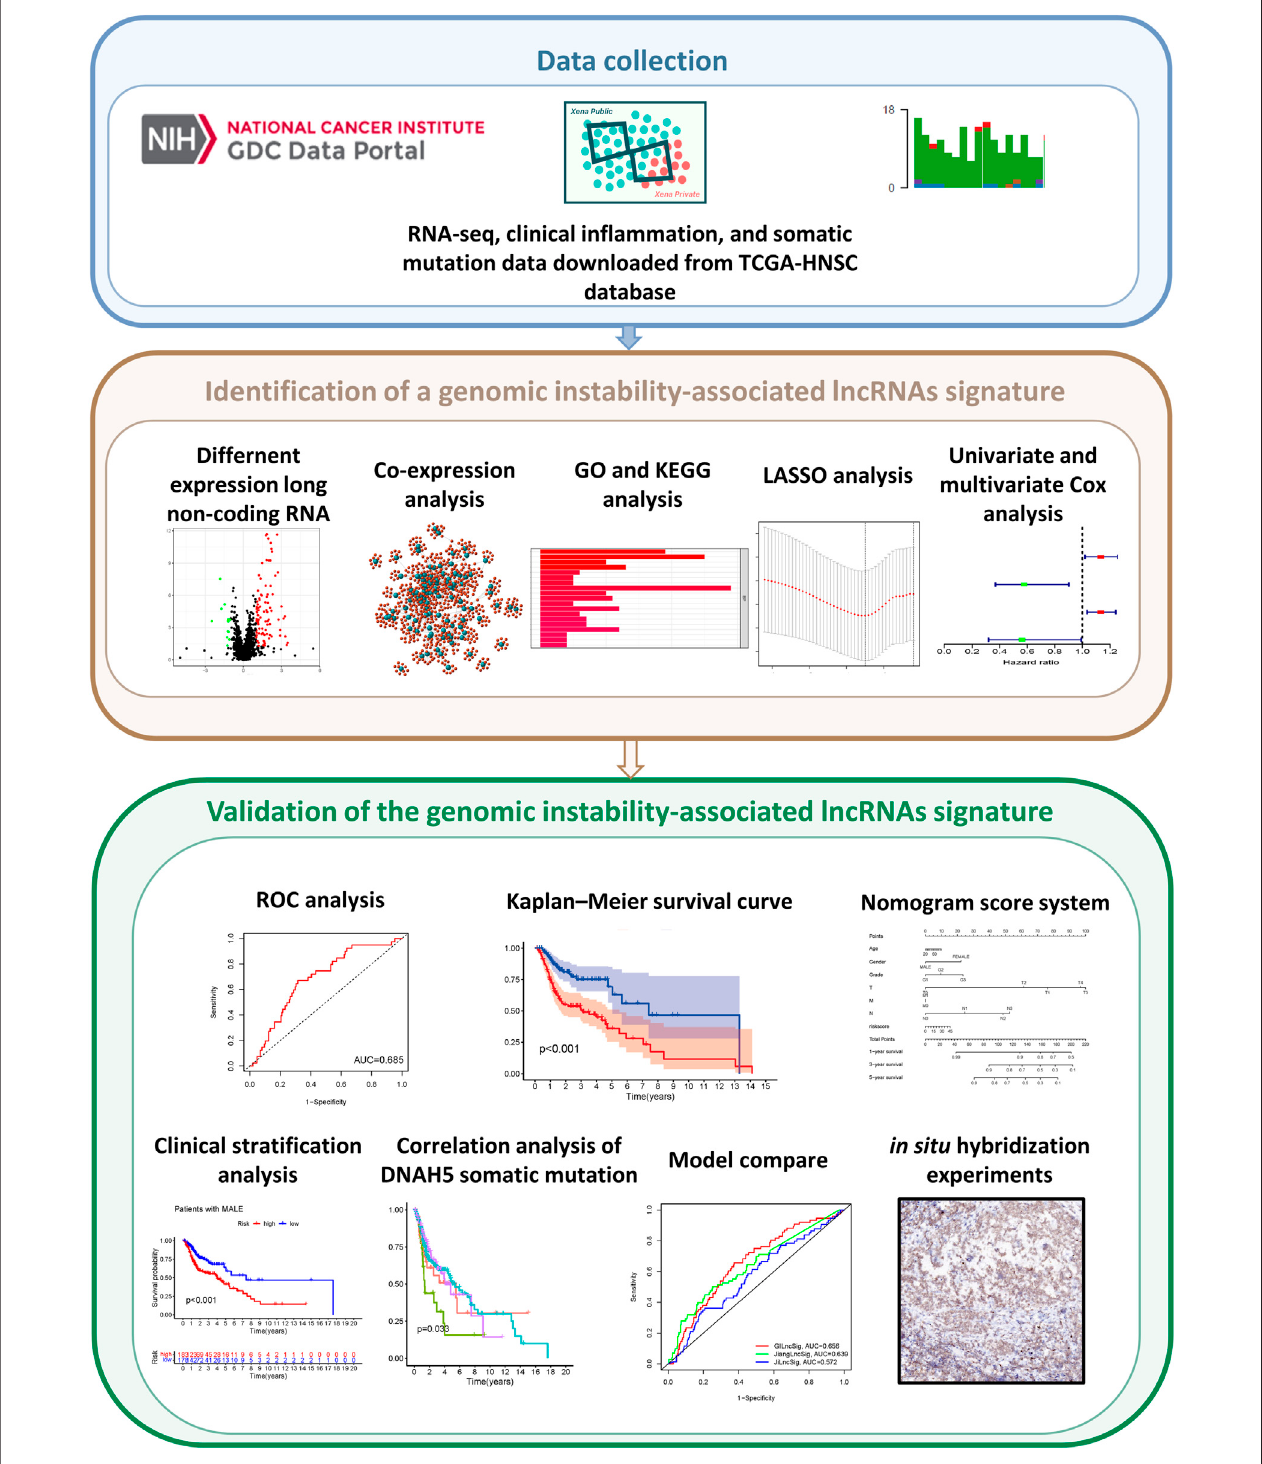
FIGURE 1 | Graphical abstract of genomic instability-associated lncRNAs signature establishment in head and neck squamous cell carcinoma.